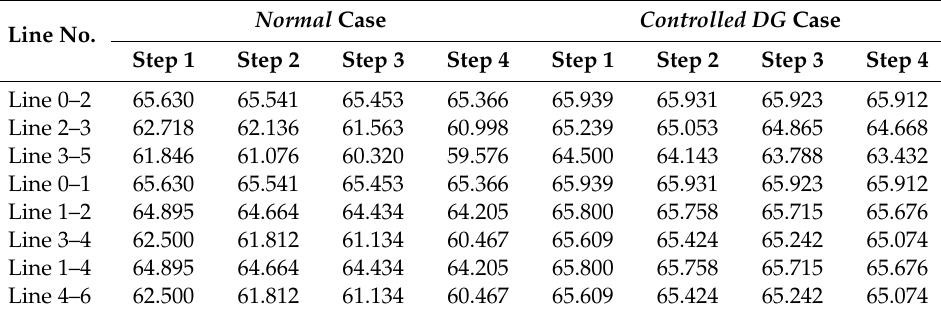
Table A5. Sending voltage values of lines for all steps and both cases (kV). Line No.